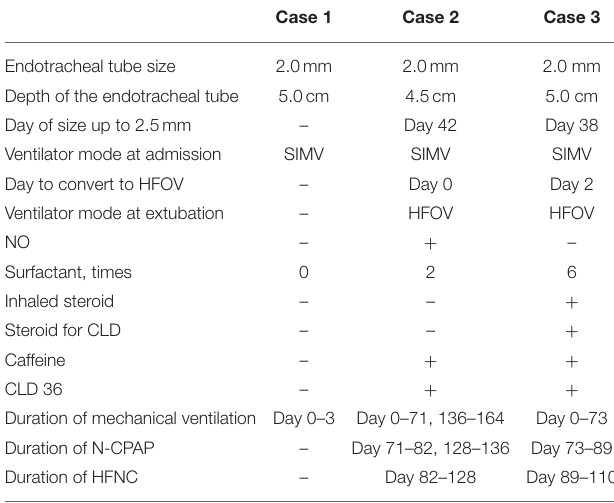
TABLE 4 | Respiratory management for the